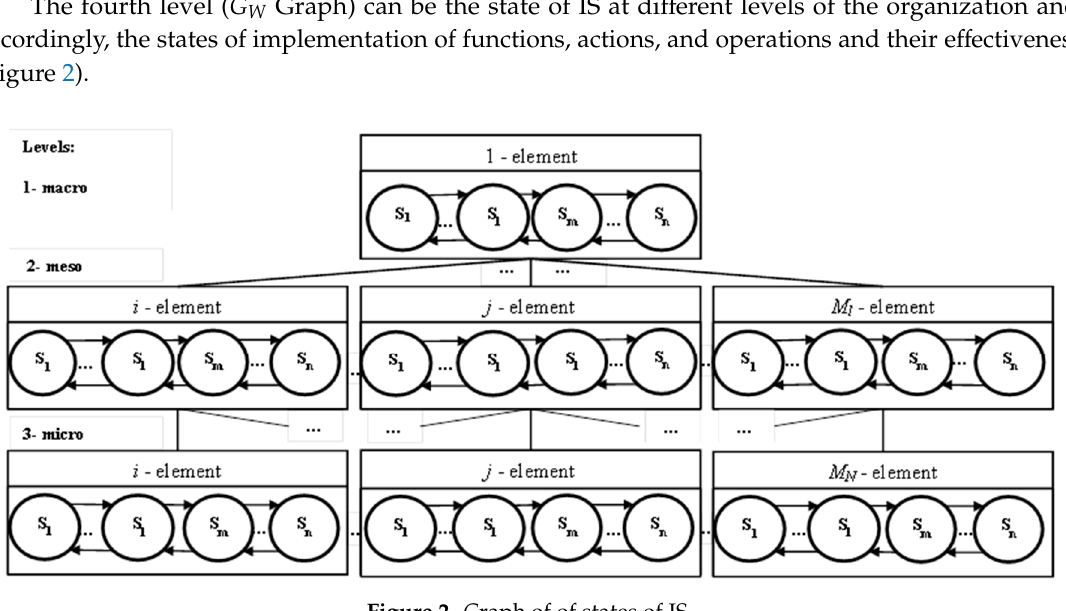
Figure 2. G raph of of states of IS.